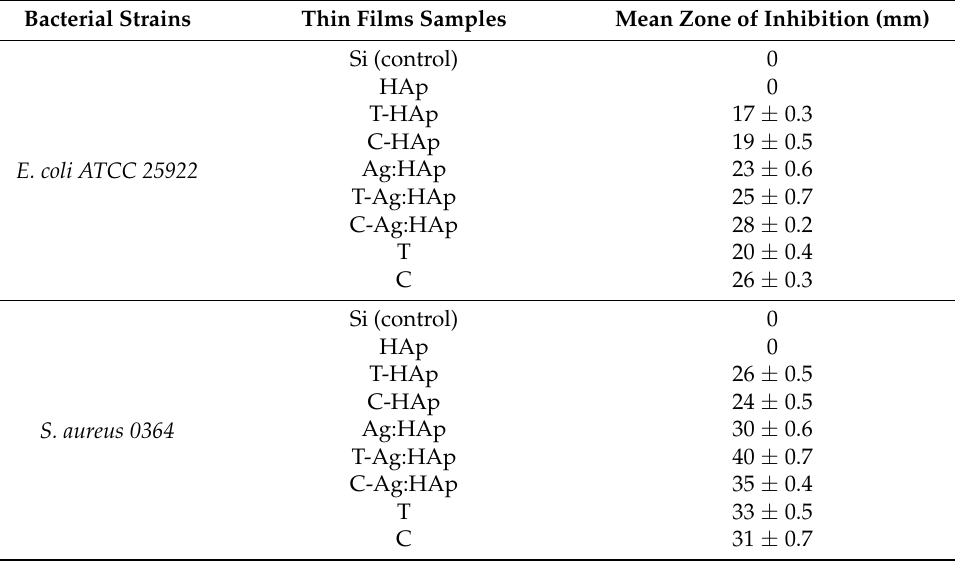
Table 1. Antibacterial activity of HAp, T-HAp, C-HAp, Ag:HAp, T-Ag:HAp, C-Ag:HAp, Ciprofloxacin (C) and Tetracycline (T) thin films against E. coli ATCC 25922 and S. aureus 0364 bacterial strains. Bacterial Strains Thin Films Samples Mean Zone of Inhibition (mm)